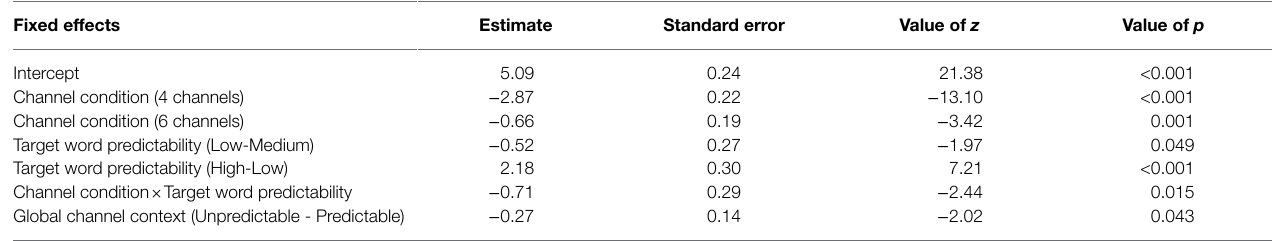
TABLE 3 | Estimated effects of the best fitting generalized (binomial logistic) mixed-effects model accounting for the correct word recognition.